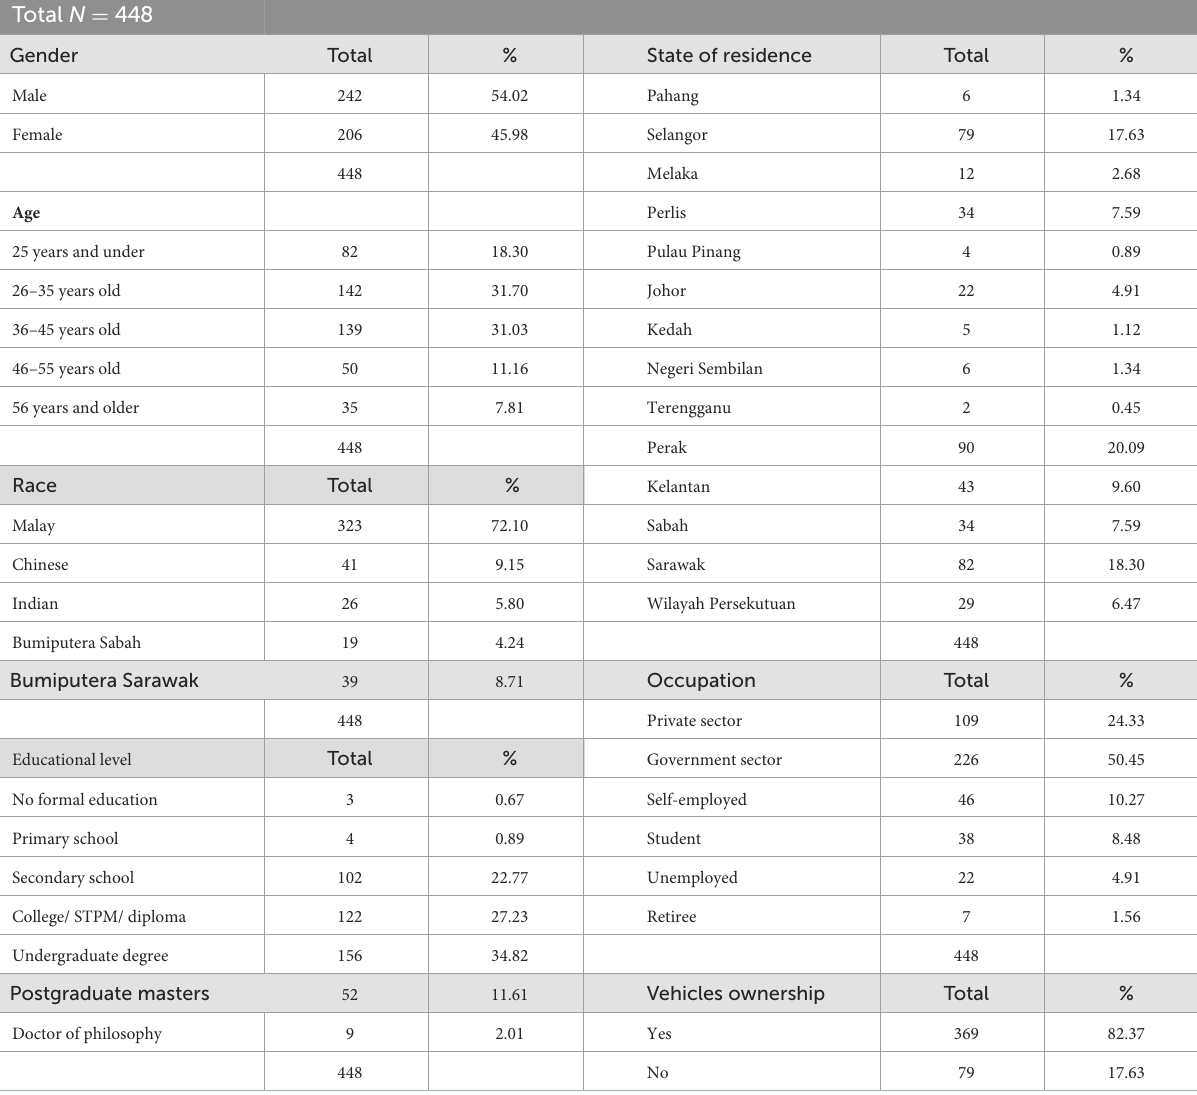
TABLE 1 Sample characteristics and key